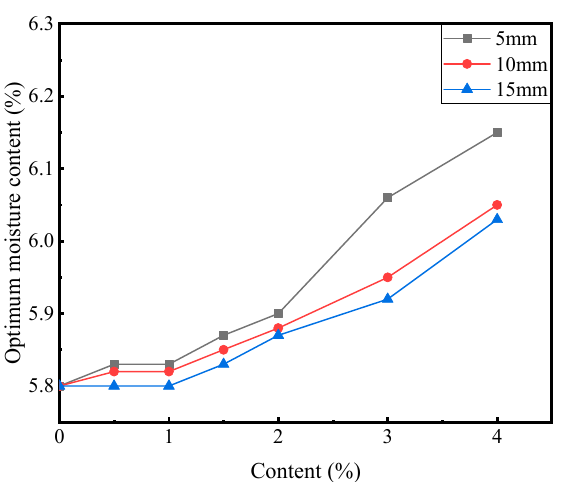
Figure 3. Relationship between the optimum moisture content and fiber content.